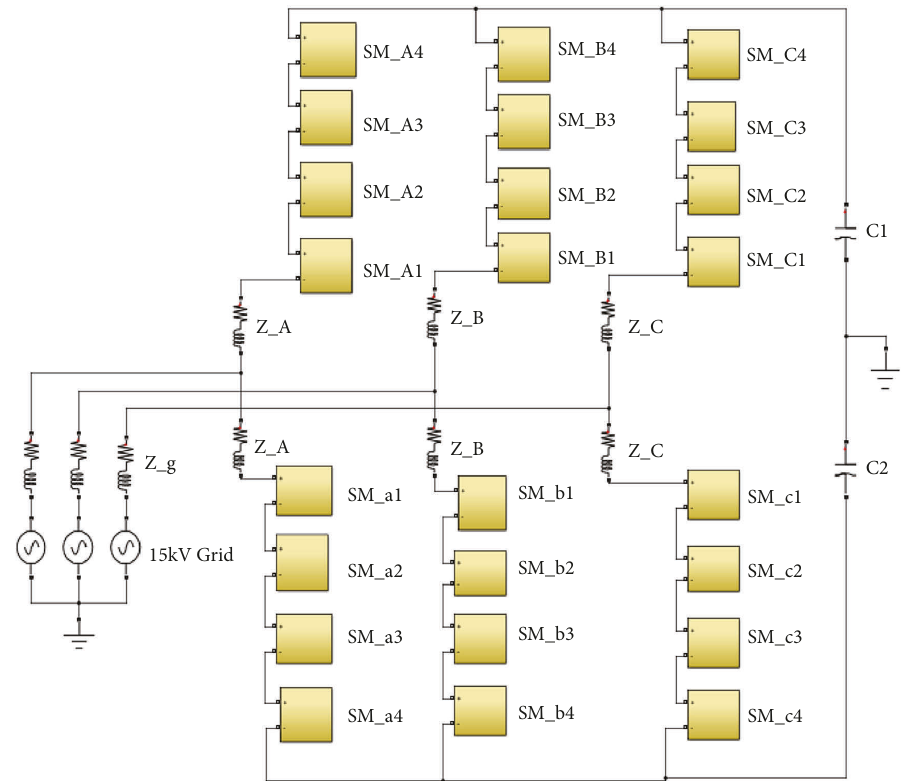
Figure 3: FS_MMC developed in MATLAB/Simulink.